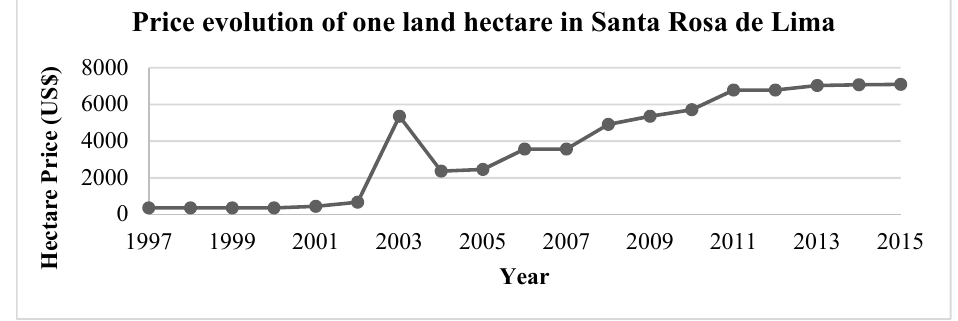
Figure 4. Price evolution of one rural hectare in Santa Rosa de Lima. Source: [66].